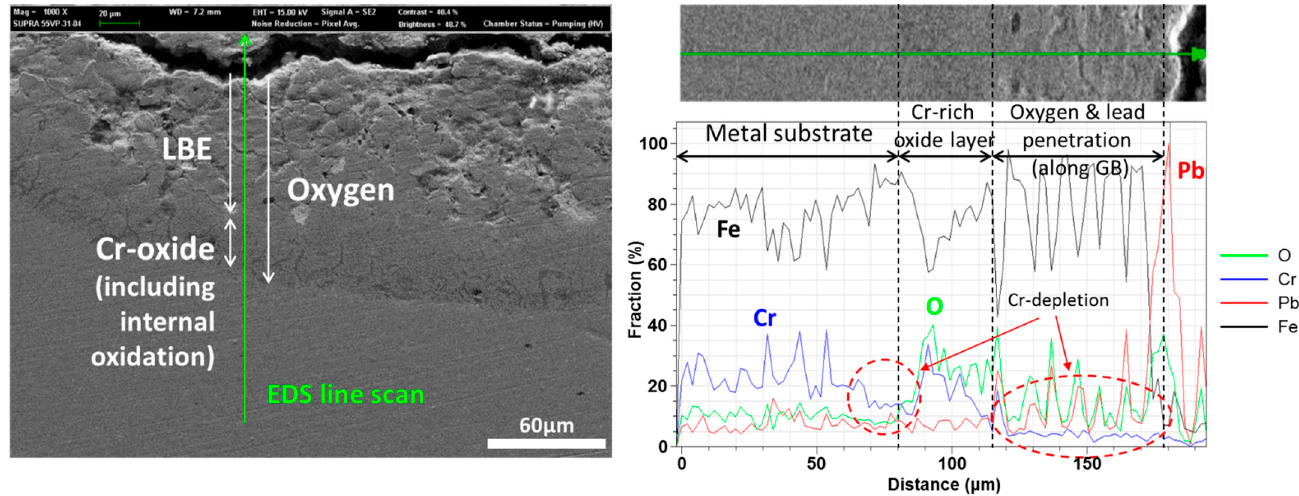
Figure 9. EDS analysis of the HT9 metal substrate close to the severely LBE-penetrated region after 2000 h at 600 °C.